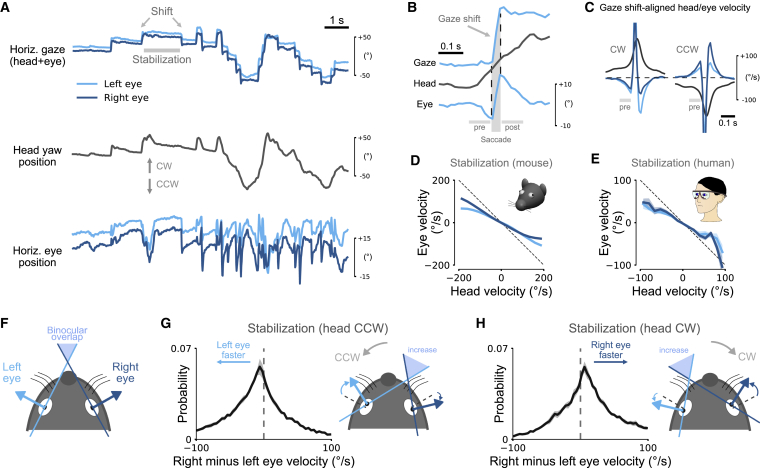
Head and Eyes Contribute to a “Saccade and Fixate” Gaze Pattern(A) Horizontal positions of the two eyes (bottom), angular head yaw position (middle), and gaze (head + eye, top) during 12-s segment in a freely moving mouse selected to highlight the saccade and fixate pattern. Small-amplitude, jerky eye movements and large-amplitude, smooth head movements combine to produce the saccade and fixate gaze pattern.(B) Magnified traces for a single gaze shift from the recording in (A). Head movement is accompanied by an initial counter-rotation of the eye before the gaze saccade. Vertical and horizontal gray bars indicate saccade and pre/post periods, respectively.(C) Gaze shift-aligned head and eye velocity traces for clockwise (CW, left) and counter-clockwise (CCW, right) gaze shifts. 44,396 gaze shifts from 5 mice (22,226 CW and 22,170 CCW); mean ± SEM (smaller than line width).(D) Relation between horizontal eye and head velocity during stabilization periods (example period marked in A). Eye movements between saccadic gaze shifts counteract head rotations; mean ± SEM (smaller than line width). Dashed line indicates complete offsetting counter-rotation; same data as in Figure 1C.(E) The same as in (D) but for humans wearing head-mounted eye goggles.(F) Illustration of monocular left and right visual field (about 180°) and horizontal binocular overlap.(G) Left: distribution of the difference in right and left eye velocity during stabilizing eye movements (CCW head rotation); mean ± SEM for 5 mice. Right: illustration of consequence of asymmetric nasal-to-temporal and temporal-to-nasal eye velocity on binocular overlap (increase relative to setting shown in F). At the same time, gaze stabilization is enhanced for the left eye during leftward turn.(H) The same as in (G) but for CW head rotations. Enhanced gaze stabilization for the right eye for mouse turning to the right.See also Figure S3.